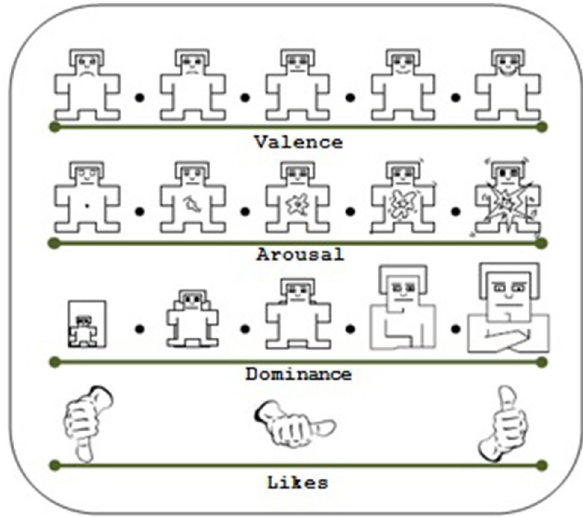
Fig. 3 SAM and thumbs- down /thumbs- up